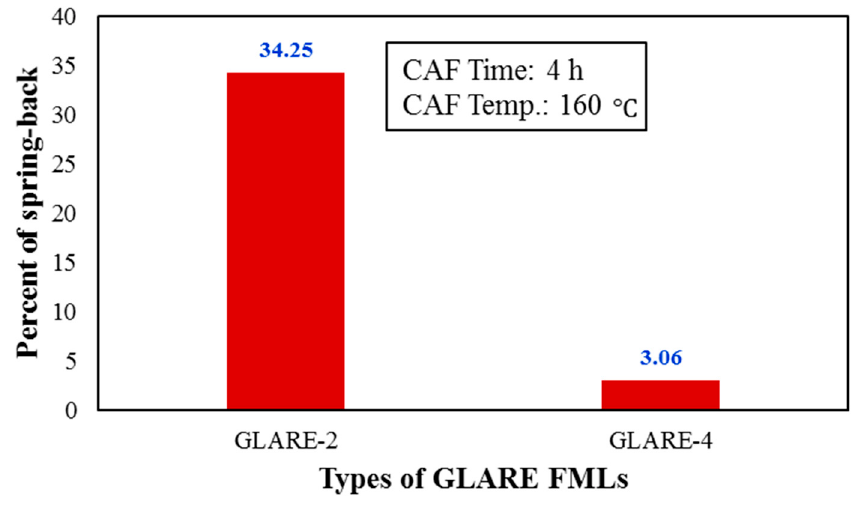
Figure 9. Effect of stacking sequence of composites layer on the springback behavior of GLARE-2 and GLARE-4 at CAF time 4h and temperature 160 °C.